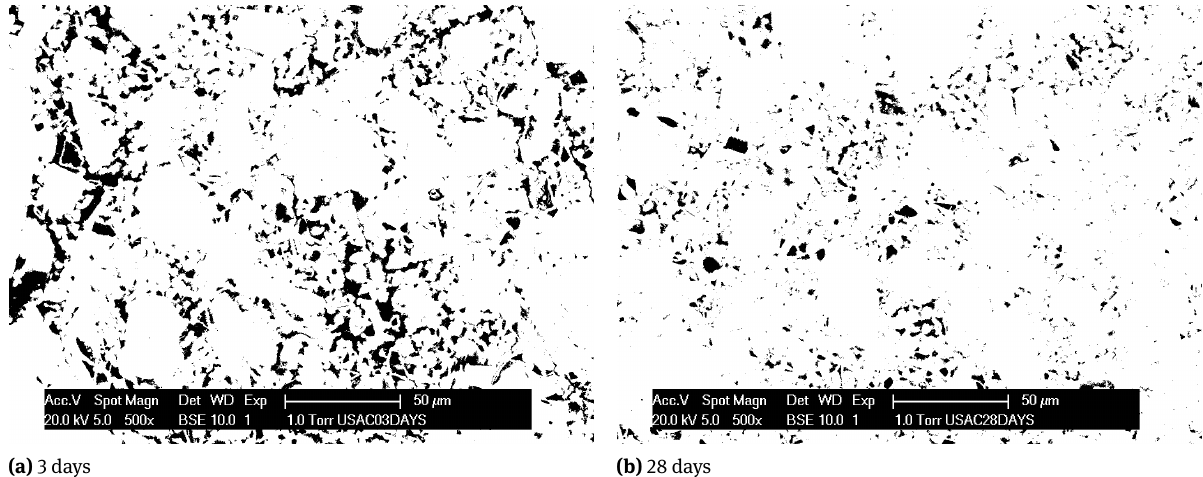
Figure 3: BSE images of the pore structure (black colour) of the cement paste at different age.